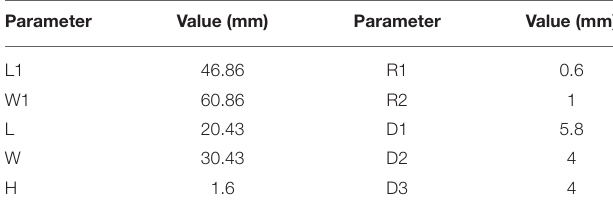
TABLE 2 | Detailed parameters of the proposed